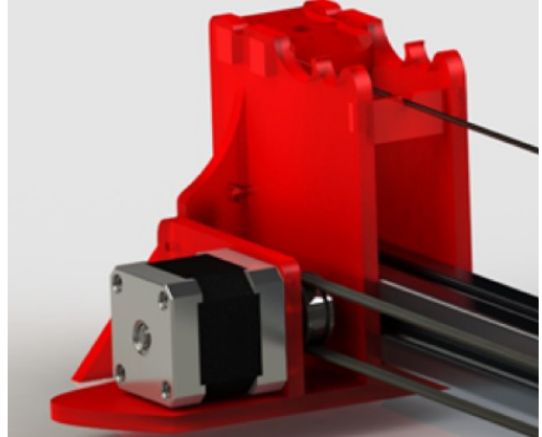
Fig. 12. Group III’s looped belt pitch-shifting system